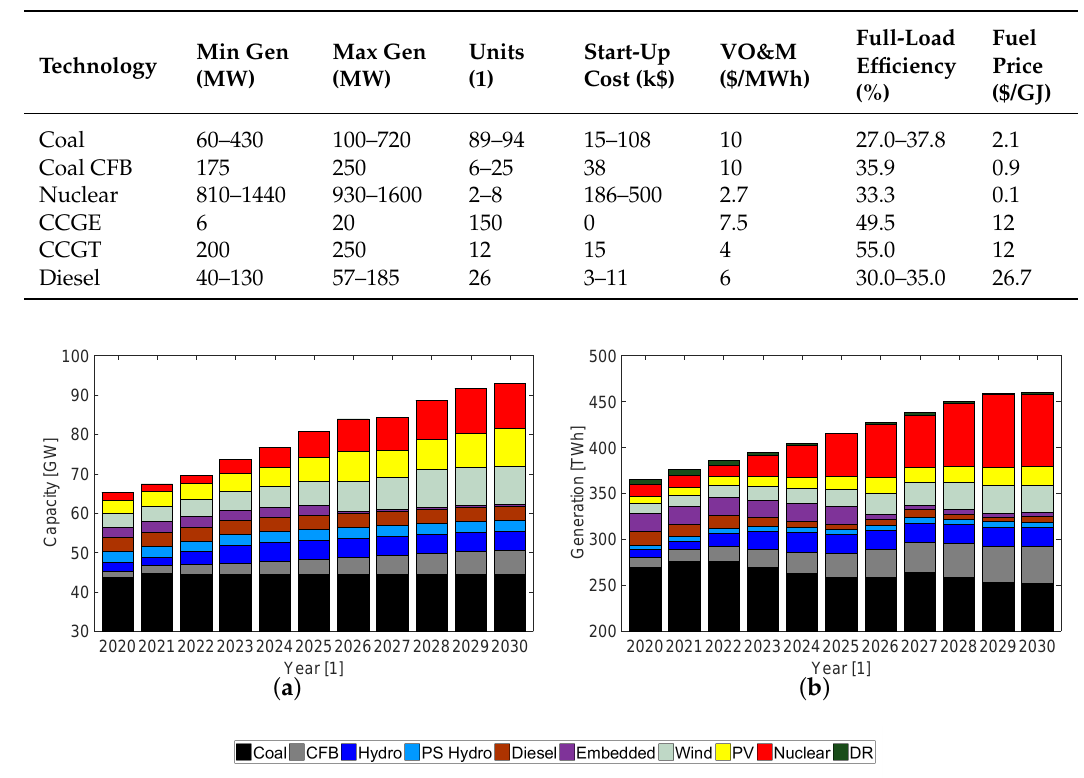
Figure 2. Yearly installed generation capacity ( a ) and generation ( b ) for the no gas